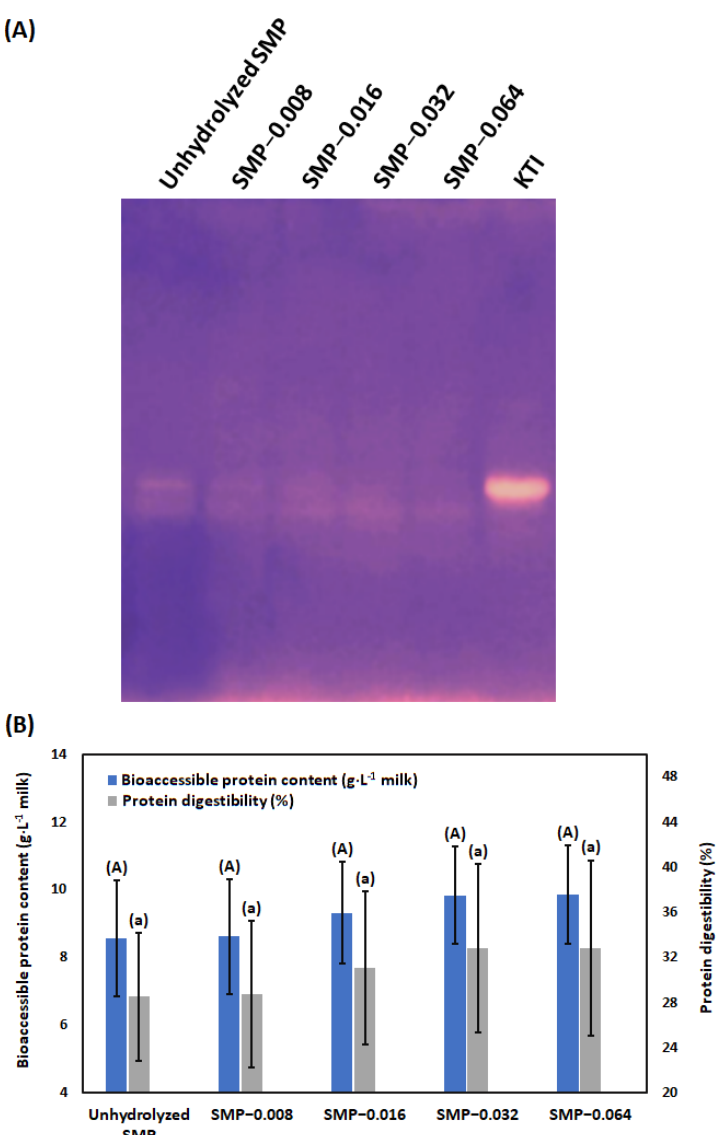
Figure 5. Inhibitory activity of KTI in unhydrolyzed and papain-hydrolyzed SMP in native (non- denaturing condition) polyacrylamide gel ( A ), bioaccessible protein content and protein digestibility of unhydrolyzed and papain-hydrolyzed SMP in vitro digestion ( B ). Results are presented by mean value with standard deviation (± values). The dissimilar al-phabet in superscript represents the significant difference between results, evaluated by the Tukey’s post hoc method.